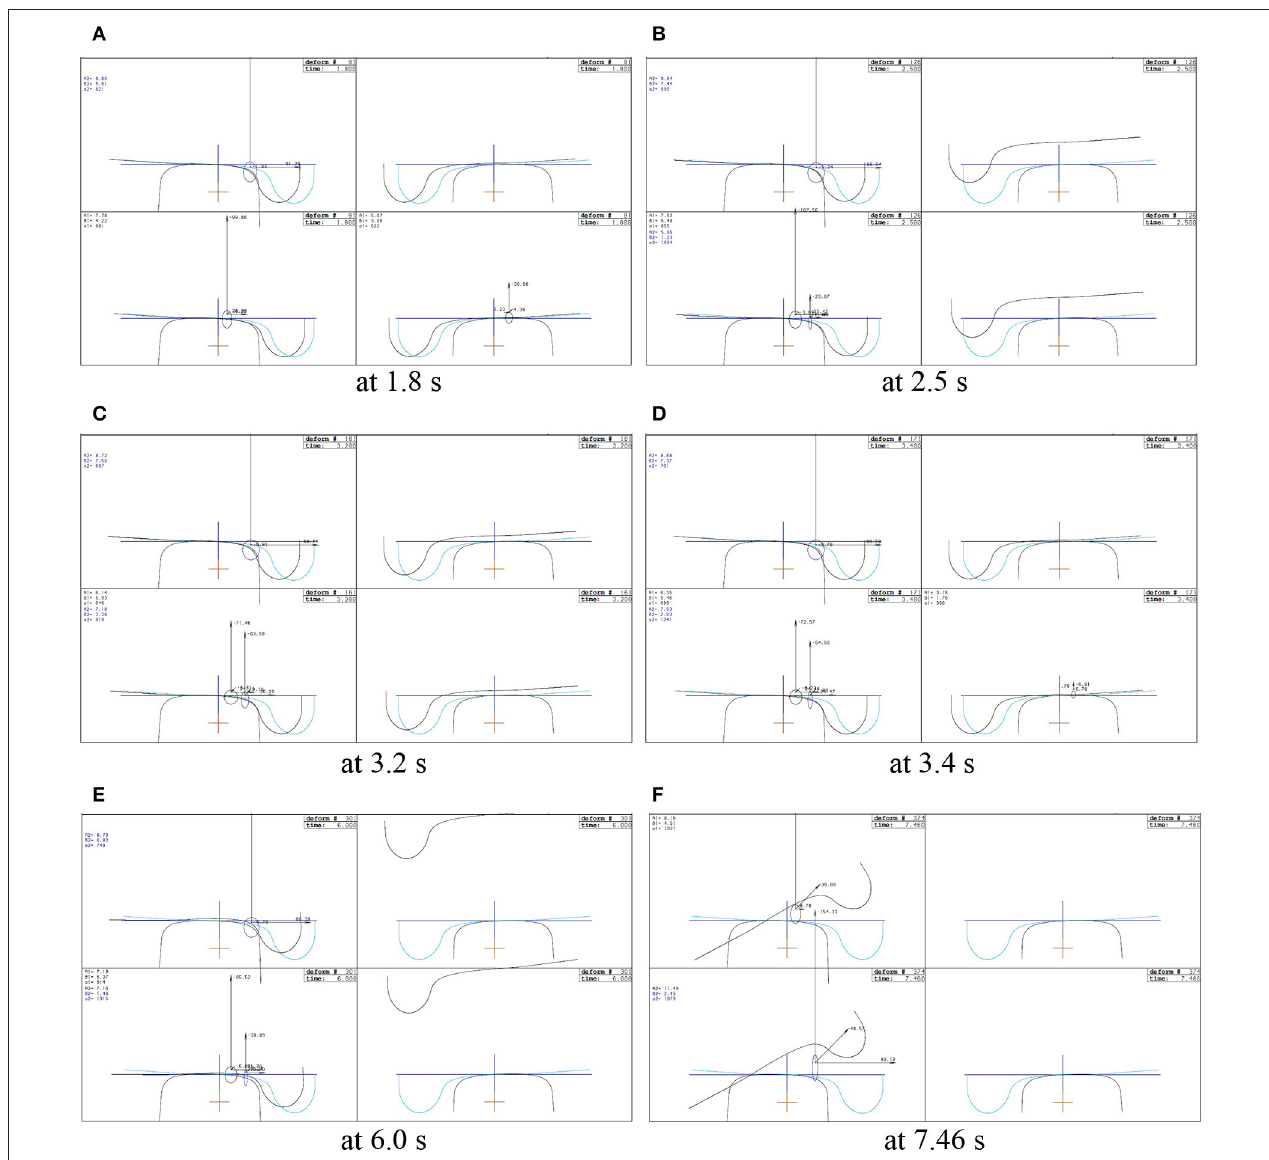
FIGURE 9 | Simulation at speed of 119km/h without guard